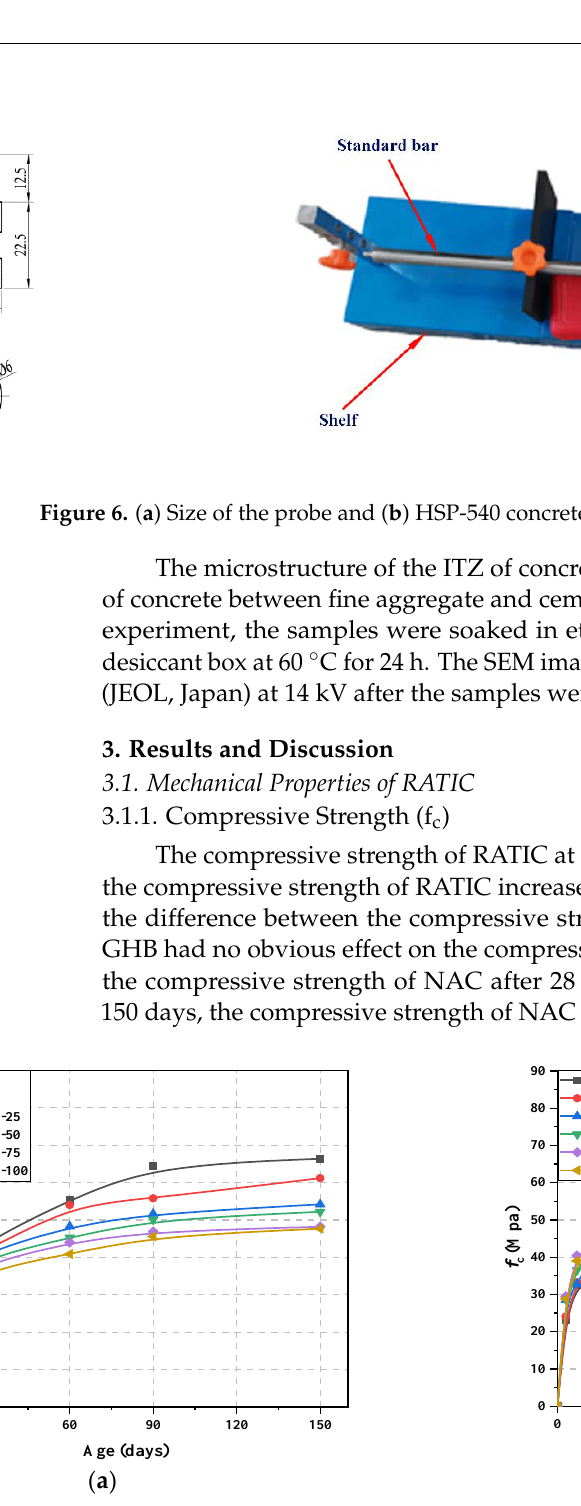
23.7% compared to that of